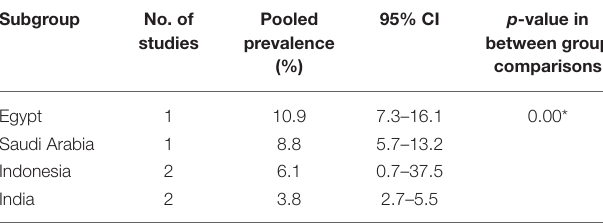
TABLE 3 | Subgroup analysis on sources of